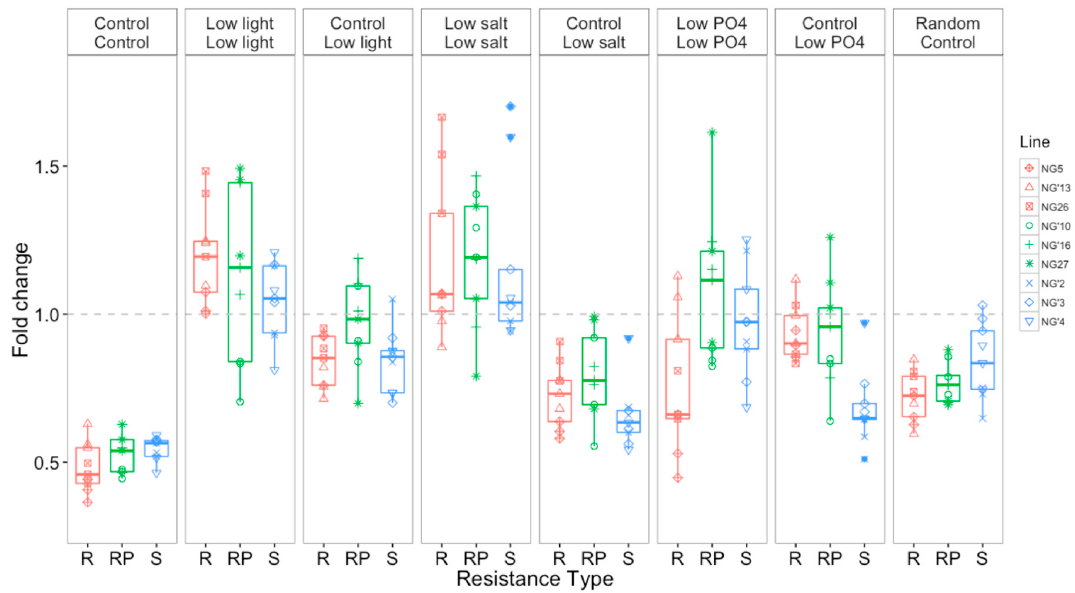
Figure 5. Competitive ability, as measured by fold difference in growth relative to a roGFP-modified O. tauri line, of evolved populations and control populations assayed in the selection environments. R = resistant, RP= resistant producer, S = susceptible. Each panel represents one assay, with populations evolved in the selection environment (top label) and competitiveness measured in the assay environment (bottom label). The dashed line represents no change (i.e., equal proportions of roGFP and competitor populations).